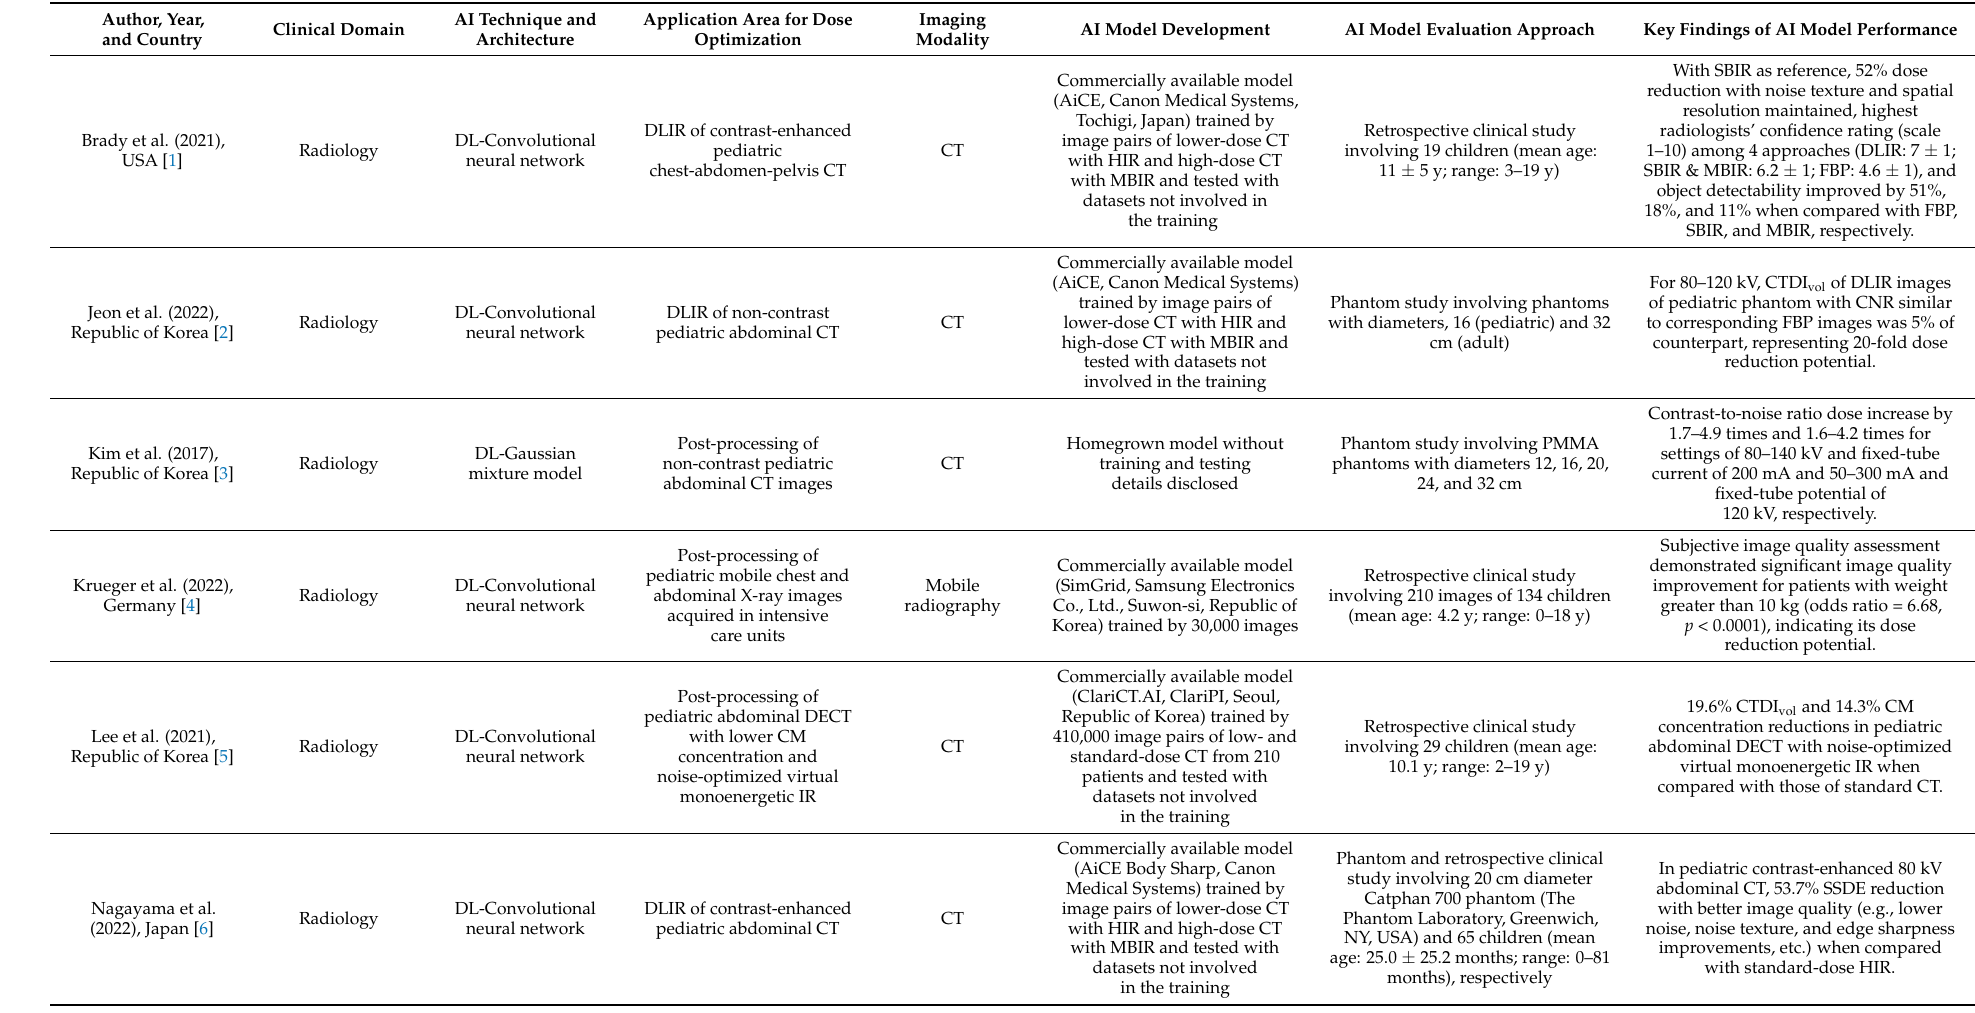
Table 1. Study characteristics of artificial intelligence for radiation dose optimization in pediatric